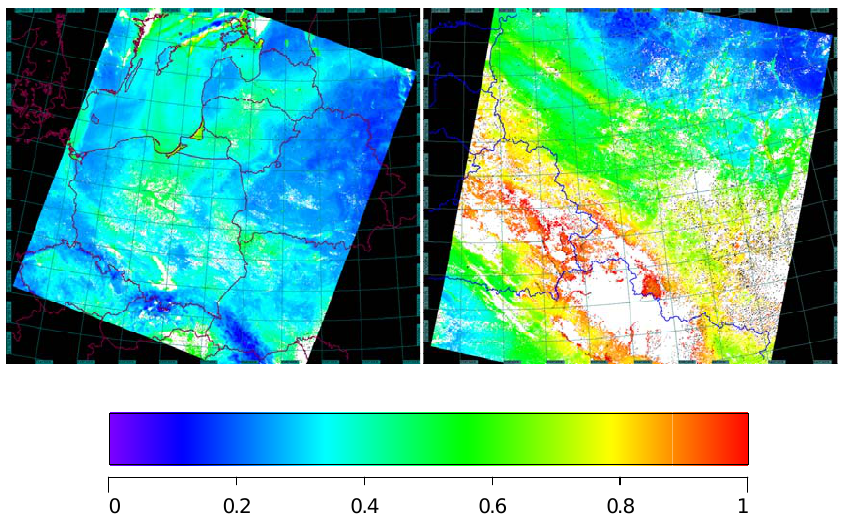
Fig. 11. AOT distribution over presented in Fig. 10 regions retrieved with the FAR